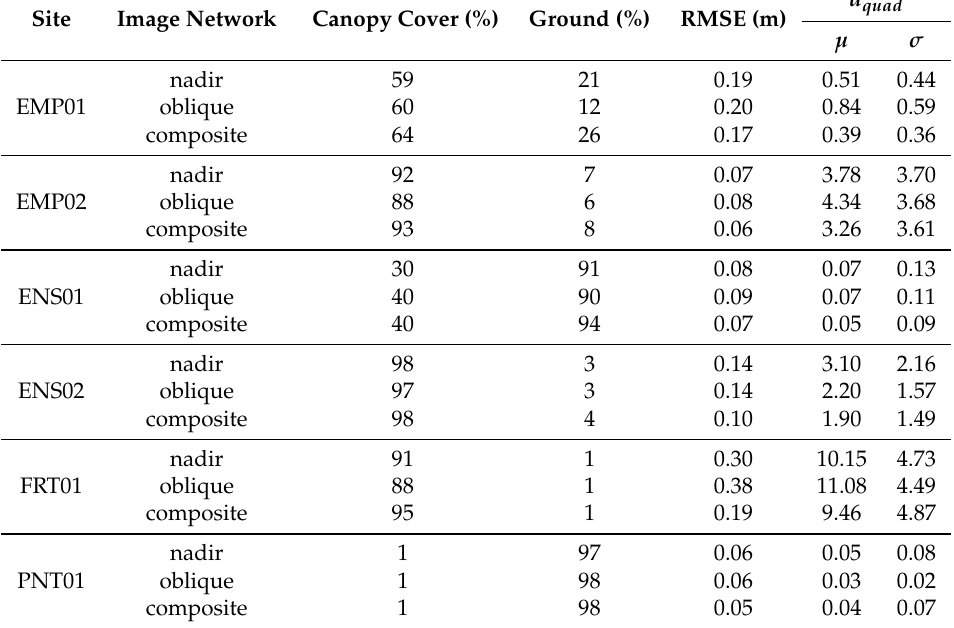
Table 4. The percentage of ground observed at each site and for each image network solution. Canopy cover is determined based on the percentage of cells containing a point above 1.5m in any of the three solutions. RMSE and d quad values for comparison to field measured ground height are also